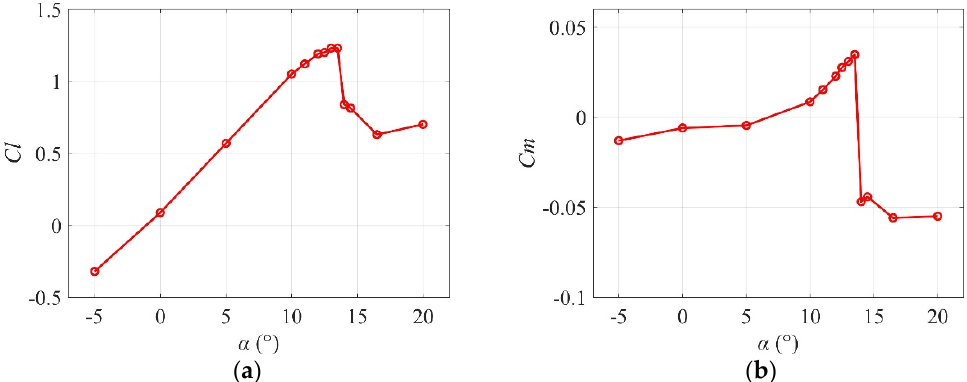
Figure 3. Static stall characteristics are shown in coefficients of ( a ) lift ( Cl ) and ( b ) pitch moment ( Cm ) for the static